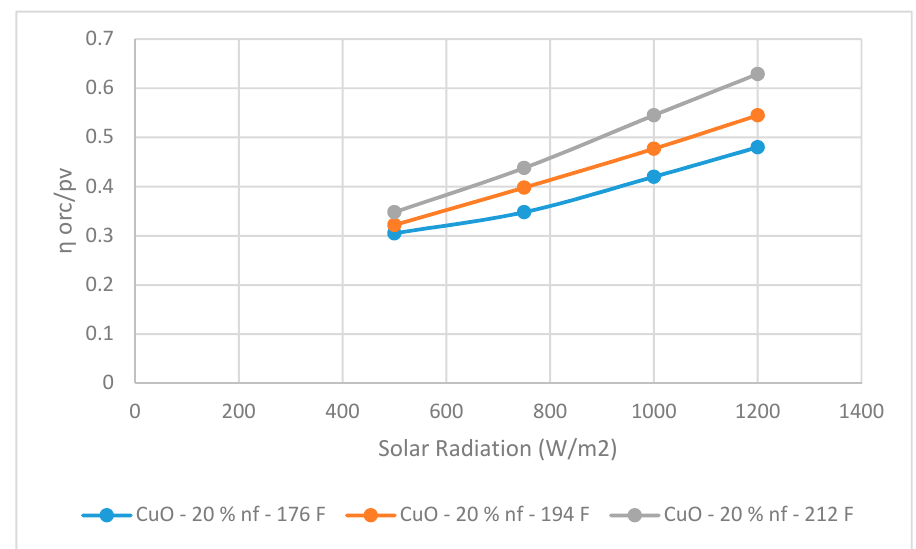
Figure 4. Hybrid system efficiency for Nanofluid Fe 3 O 4 at different temperatures and 20% volumetric concentration.